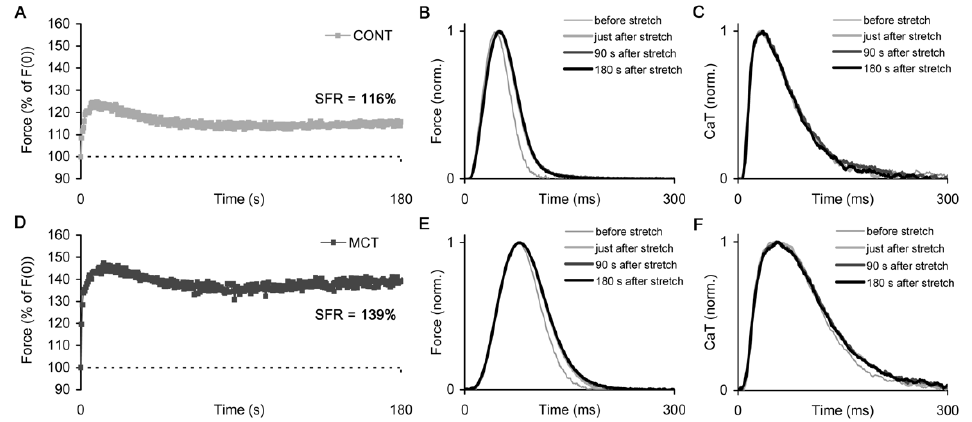
Figure 6. The representative slow force response (SFR) measured in the right atrial strip of control (CONT) and monocrotaline-treated (MCT) rats. ( A ) The SFR in an exemplary CONT atrial strip. ( B , C ) The individual traces of the isometric force and Ca transient measured during the development of SFR of the exemplary CONT atrial strip. ( D ) The SFR in an exemplary MCT atrial strip. ( B , C ) The individual traces of the isometric force and Ca transient measured during the development of SFR of the exemplary MCT atrial strip. The magnitude of SFR for these exemplary atrial strips is shown in panels ( A , D ). The time points for the curves in panels ( B , C , E , F ) are shown in the appropriate legends. The force and Ca transient traces in panels ( B , C , E , F ) are normalized to their respective peaks.